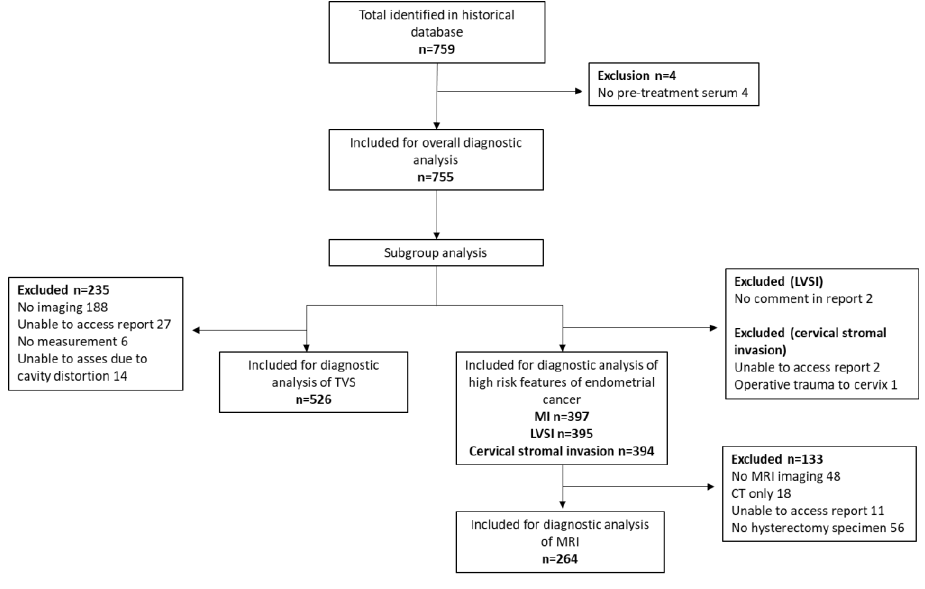
Figure 1. Study flow diagram.